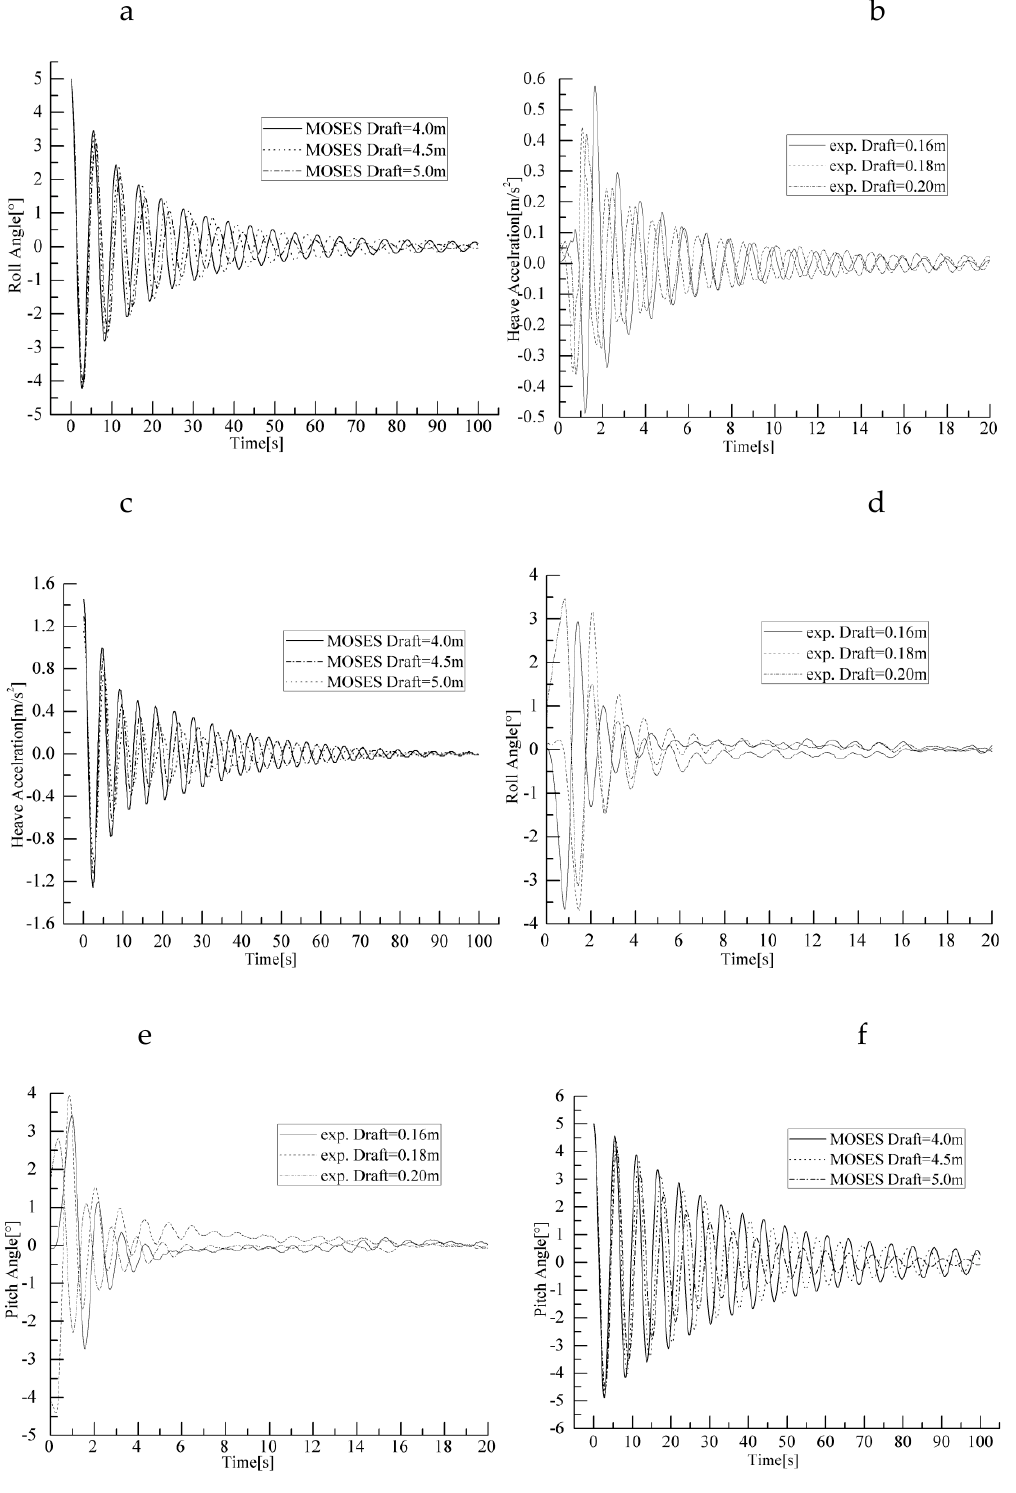
Figure 11. Experimental and simulated decay curves for free oscillation motions for drafts of three different heights: ( a ) experimental heave acceleration; ( b ) simulated heave acceleration by MOSES; ( c ) experimental roll angle; ( d ) simulated roll angle by MOSES; ( e ) experimental pitch angle; and ( f ) simulated pitch angle by MOSES.